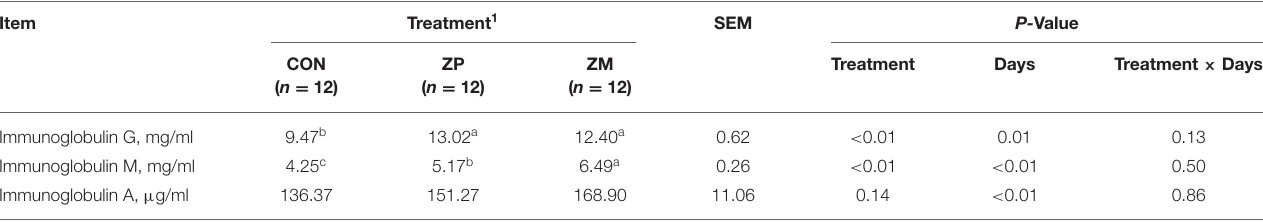
TABLE 5 | Effects of organic zinc sources on concentrations of plasma immunoglobulin in dairy calves during the first month of life (Experiment 2).